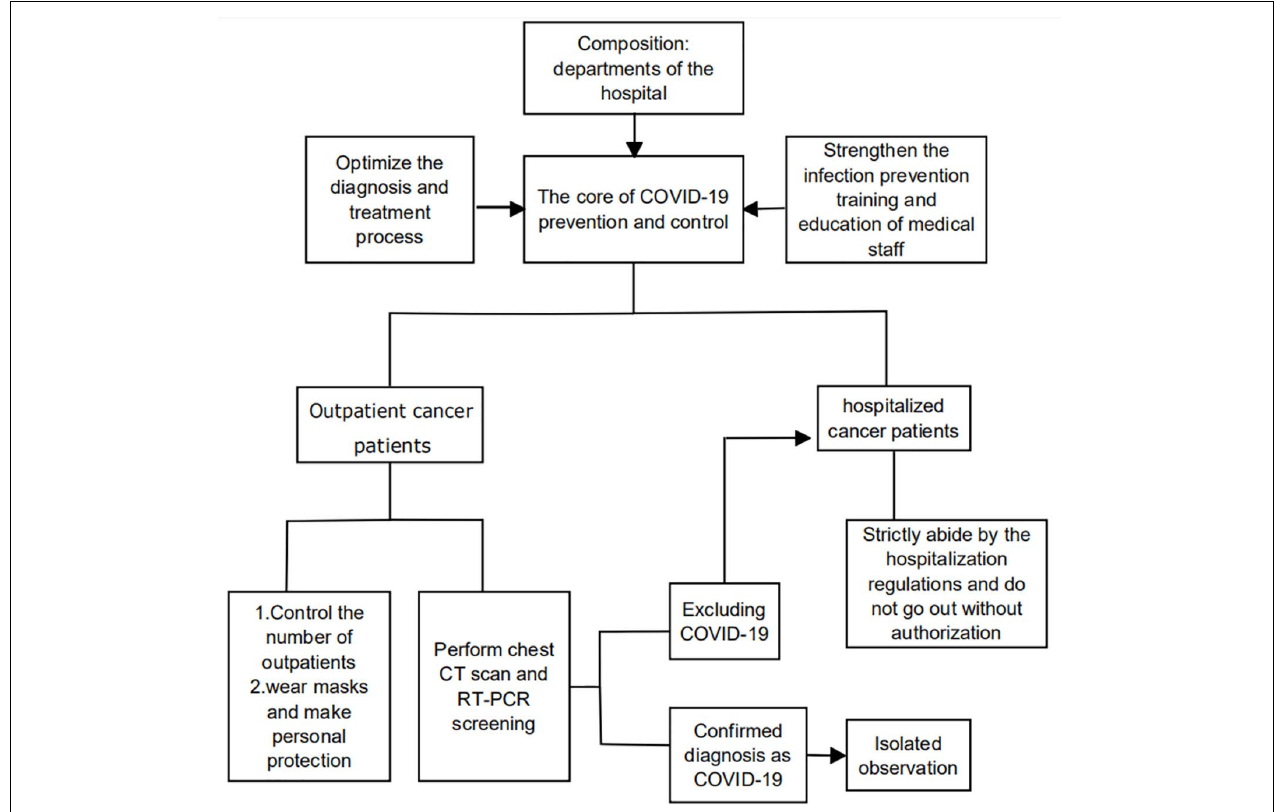
FIGURE 3 | COVID-19 prevention and control management in hospital